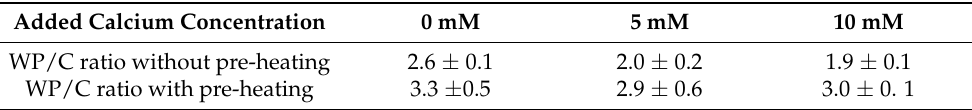
Table 3. Whey protein/casein (WP/C) ratio [-] in the permeate after filtration, with and without pre-heating, at various concentrations of added calcium. A significant difference at a level of p < 0.05 between the WP/C ratio with and without pre-heating was